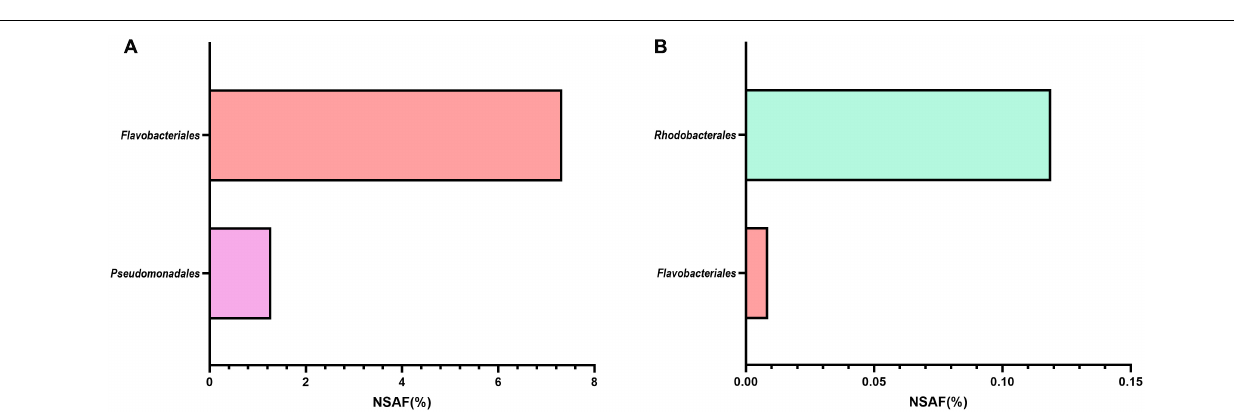
FIGURE 2 | Metaproteome expression of (A) cobalamin transport and (B) biosynthesis proteins produced by MAGs belonging to the four most abundant orders during blooms across 2010-2012. NSAF (%) represents the summed percent normalized spectral abundance factor of transport or biosynthesis proteins. Cobalamin transport and biosynthesis proteins from Pelagibacterales were not detected. The number of transport proteins contributing to the total NSAF(%) for the respective taxonomic group are as follow: Flavobacteriales : 76; Pseudomonadales : 23. Rhodobacterales cobalamin transport proteins were not detected. The number of cobalamin biosynthesis proteins contributing to the total NSAF(%) for the respective taxonomic group are as follow: Flavobacteriales : 1; Rhodobacterales : 4. Only the last enzyme in the cobalamin biosynthetic pathway was taken into consideration for this calculation: MMAB/pdu = Cobalamin adenosyltransferase; cobW = cobalamin biosynthesis